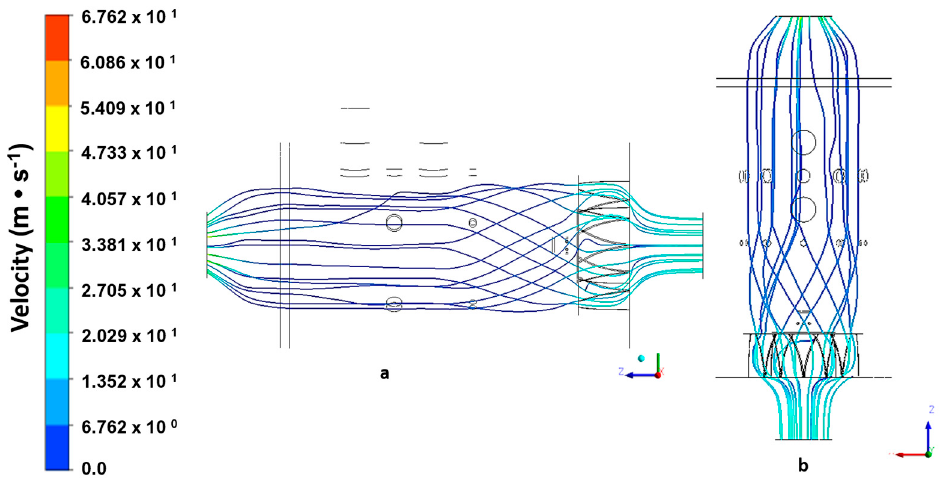
Figure 6. Flow streamlines in the combustion chamber: ( a ) side view yz plane; ( b ) top view xz